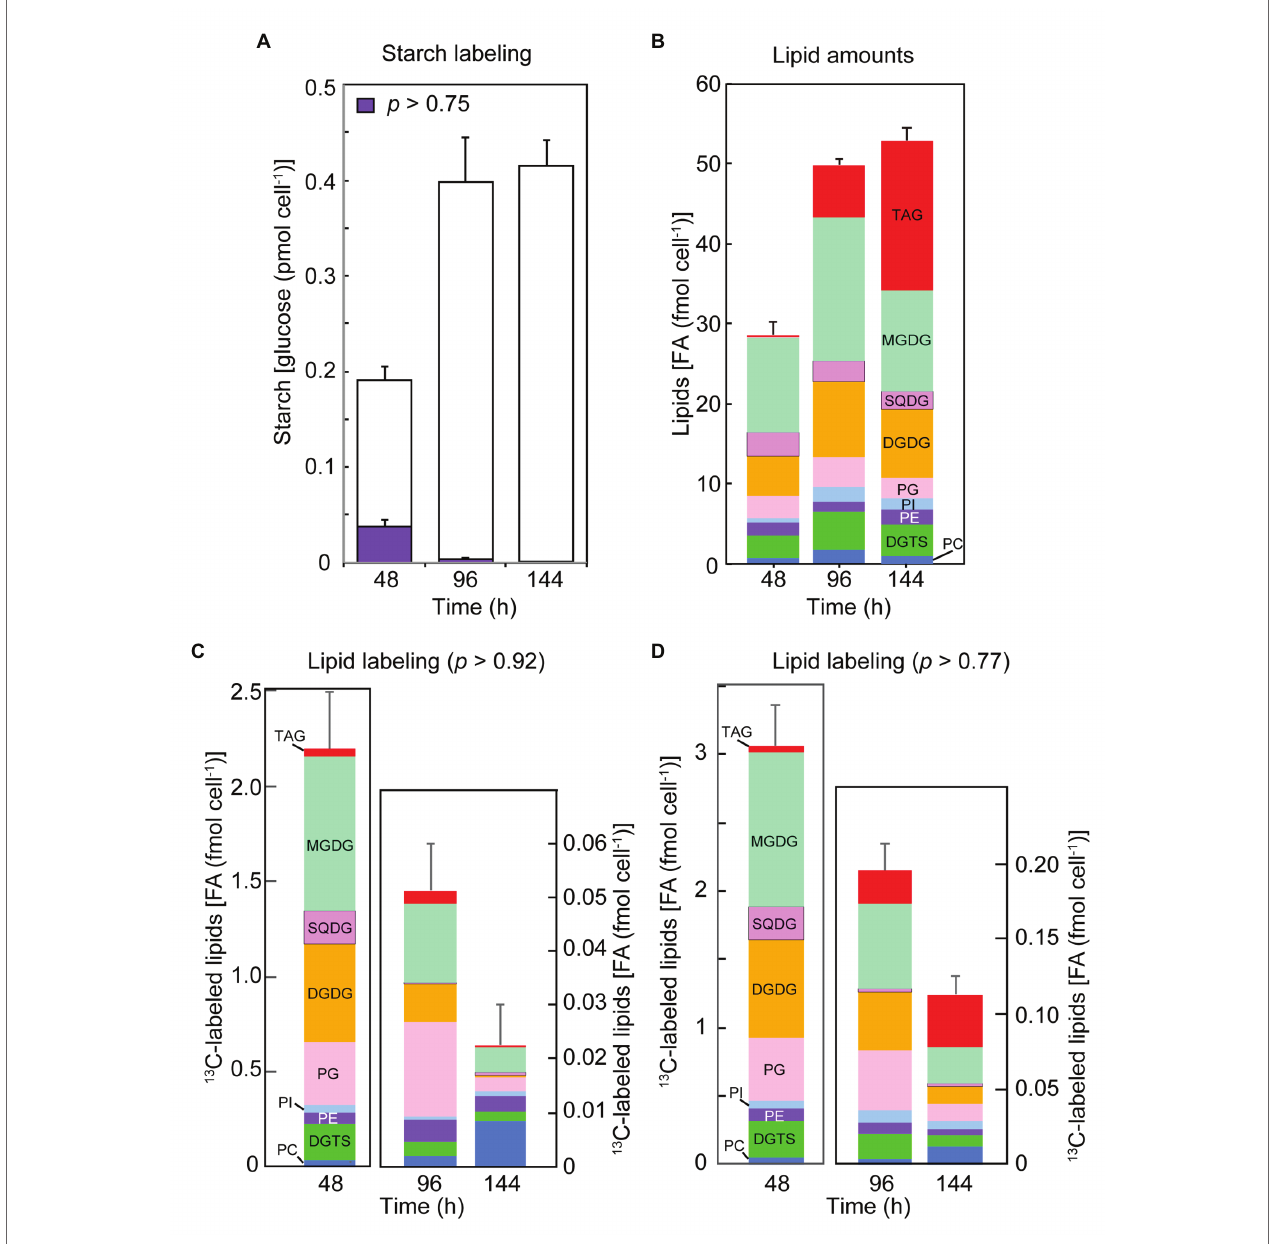
FIGURE 3 | The contents of total and labeled fractions of starch and lipids after the labeling for 2 h with sodium [ 13 C]bicarbonate at different growth stages. (A) The amounts of total and labeled ( p > 0.75) fraction of starch. White bars show unlabeled glucose, while purple bars show labeled glucose. (B) The amounts of lipid classes. (C) The amounts of labeled lipids ( p > 0.92). (D) The amounts of labeled lipids ( p > 0.77). Lipid classes are color-coded. Each value represents the mean ± SE of three independent